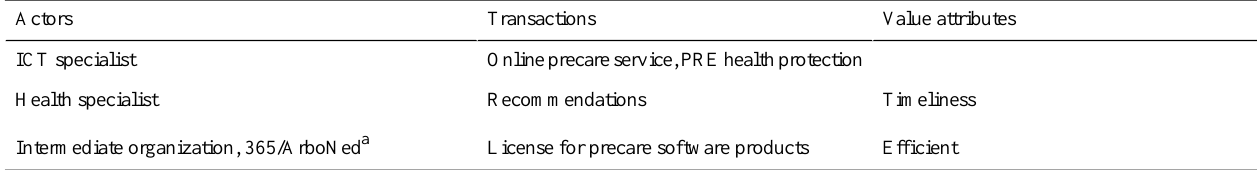
Table 3. Online service provider overview of actors, transactions, and value